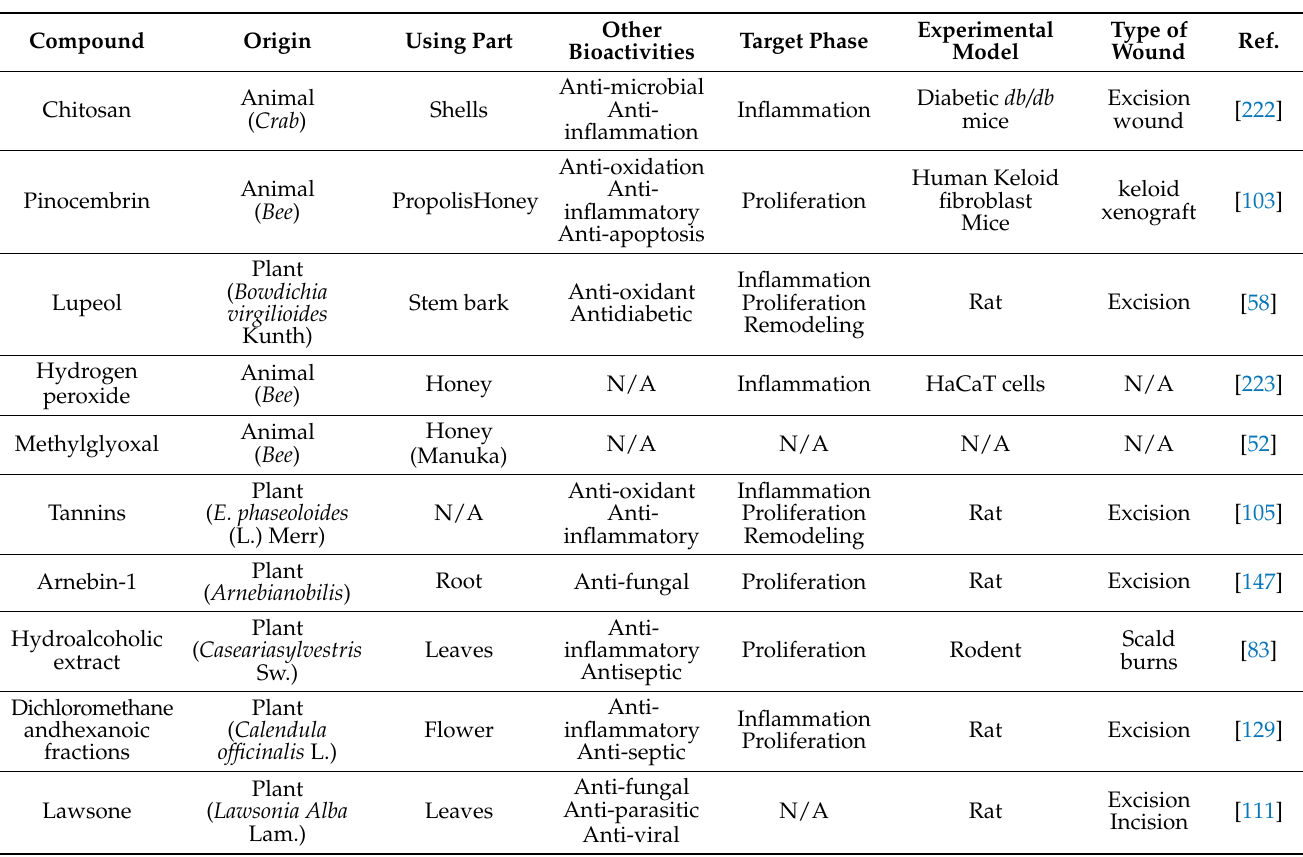
Table 3. Compounds with anti-bacterial.